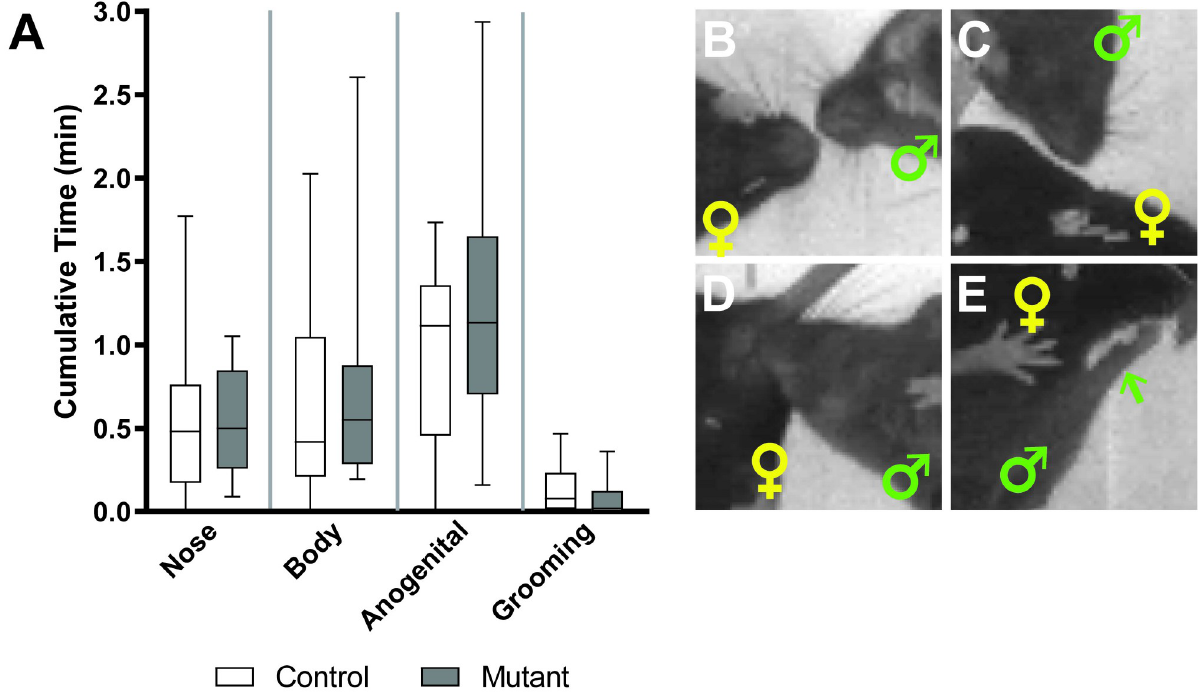
Fig 1. Female-directed social behaviors are unaffected in Pea3 null mice. (A) The cumulative time spent performing social behaviors in unaffected in Pea3 null (N = 17) vs control (N = 13) males (multiple Mann-Whitney tests, p nose < 0.483; p body < 0.408; p anogenital < 0.432; p grooming < 0.146). Representative images of active social behaviors directed to the female nose (B), body (C), and anogenital (D), and grooming (E) behaviors. Male and female positions are marked by green and yellow symbols, respectively. In (E), the green arrow denotes position of male forelimb during grooming.